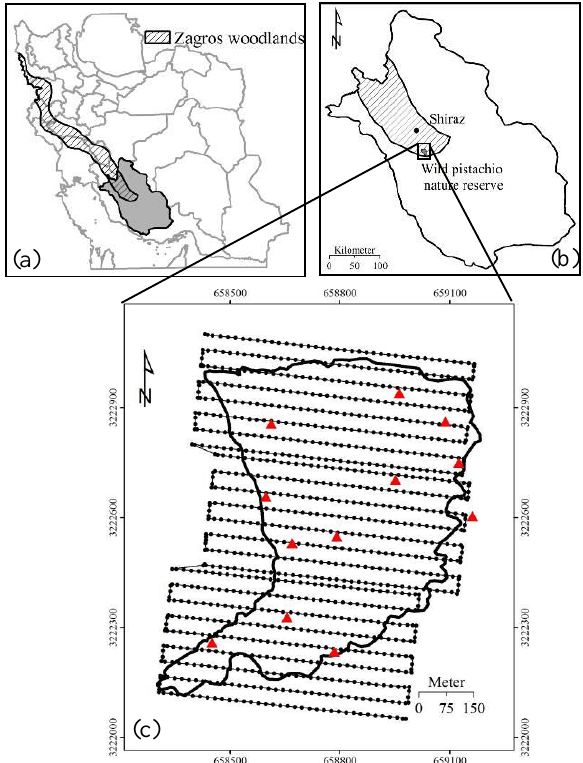
Figure 1. Map identifying the 45-ha study area in wild pistachio nature reserve (a) in Zagros woodlands of Fars province (a) and extent of Zagros woodlands in West Iran (b). The study area: filled circles and black lines show flight plan and red triangles indicate the location of ground control points (c).